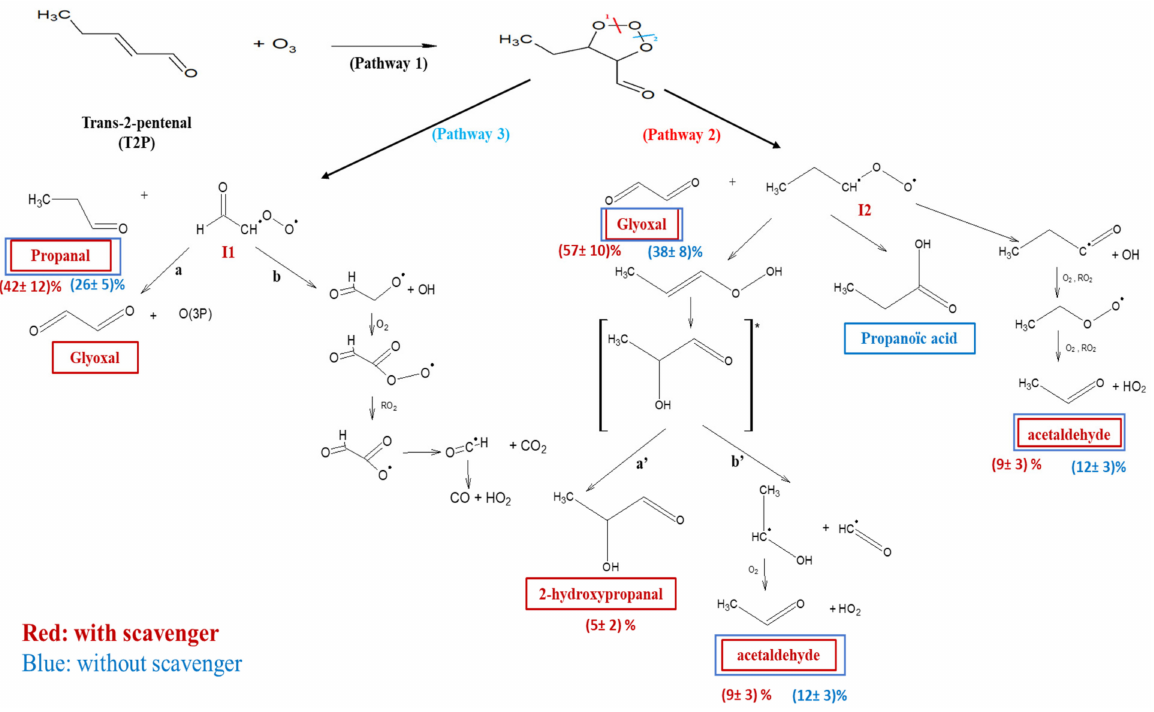
Figure 4. Proposed mechanistic scheme for the ozonolysis of T2P; framed products correspond to those identified in FTIR and GC/MS with and without